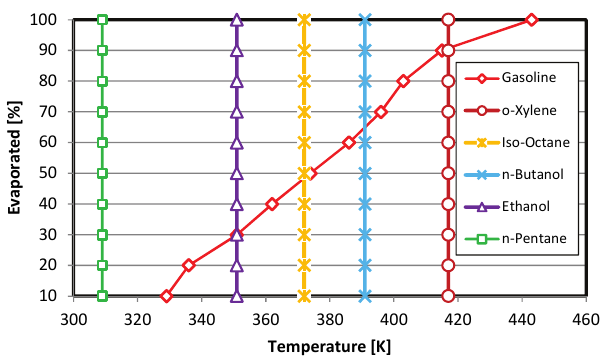
Fig. 1. Distillation curve of gasoline and other fuels